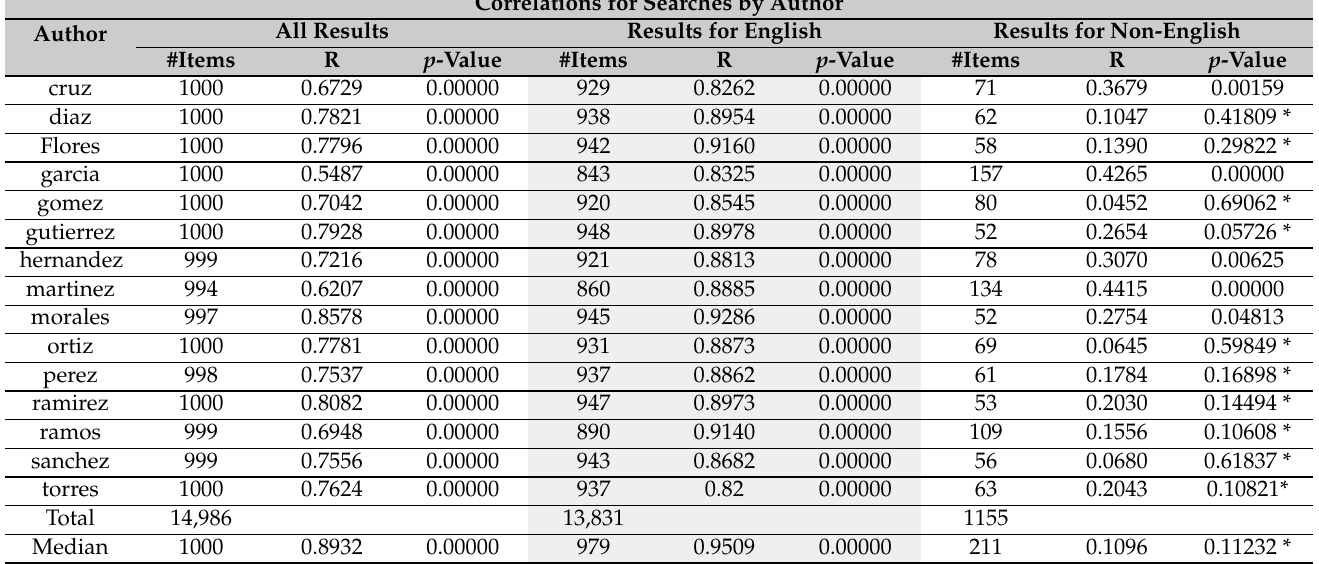
Table 7. Correlations between ranking by citations and the GS native ranking for searches by